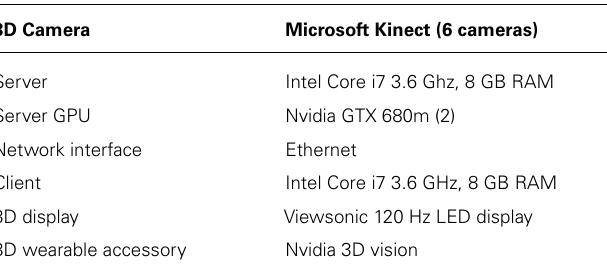
Table 1 | System configuration.